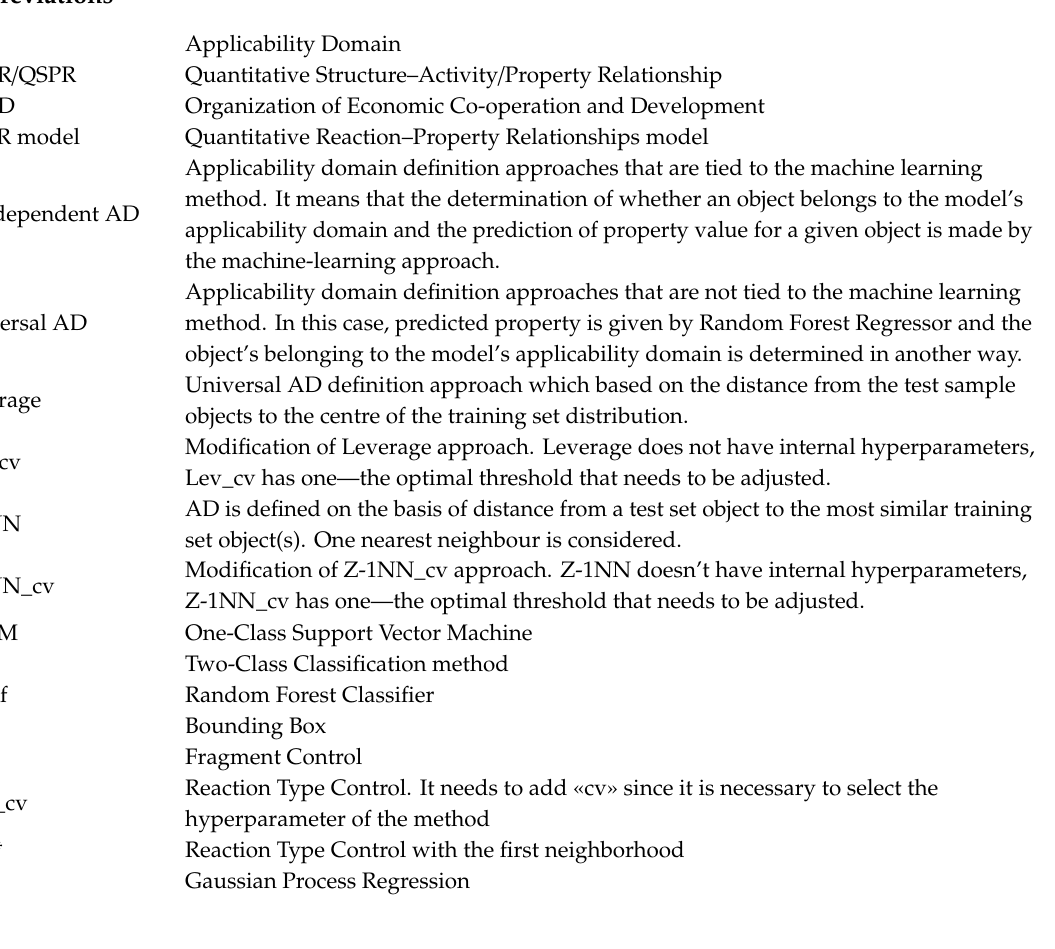
Table S1. Detailed information about the hyperparameters of AD definition approaches. Table S2. Values of four AD performance metric for all datasets for some of the individual AD definitions assessed using nested cross-validation with hyperparameters tuned in its inner loop. Tables S3–S6. Ranking of di ff erent AD definition methods for S N 2, E2, DA, Tautomerization datasets, respectively. Table S7. Ranking of di ff erent AD definition methods for all datasets. Table S8. Coe ffi cient of determination (R 2 ) and RMSE of prediction for the external test set (only reactions within AD are